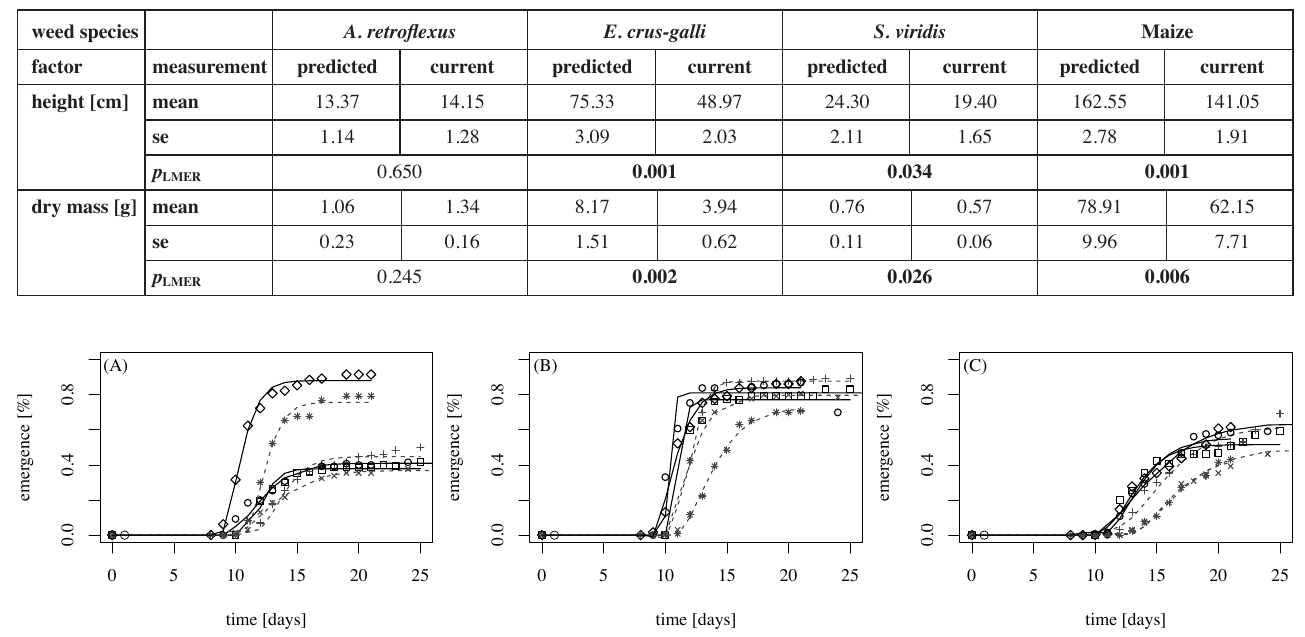
Tab. 4: Parameters of plants grown in tubs at the end of mid-growth phase for the three replications; mean and standard error (se) are given for predicted future and current climate, significant differences LMER ( p LMER ) are bold.